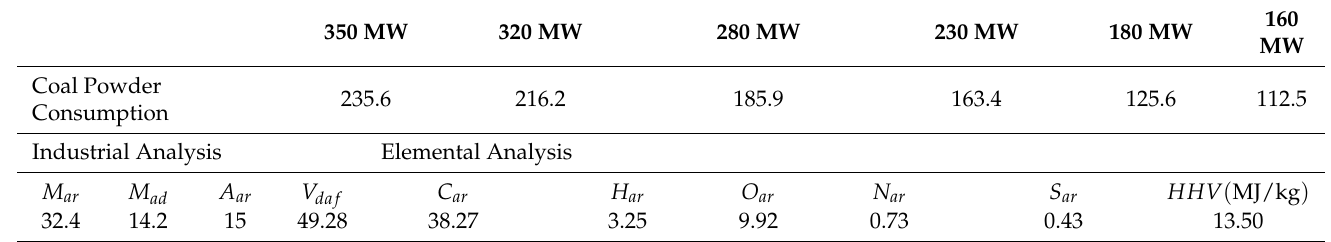
Table 1. The coal powder consumption table (t/h).